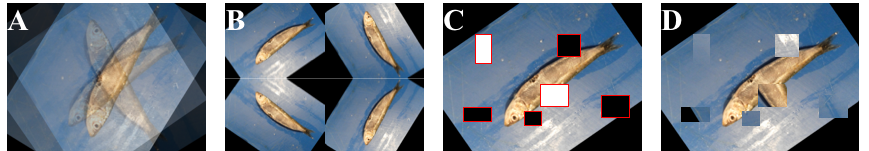
Figure 3. Illustration of enhancement methods. ( A ) Mixup; ( B ) Mosaic; ( C ) Cutout; ( D )